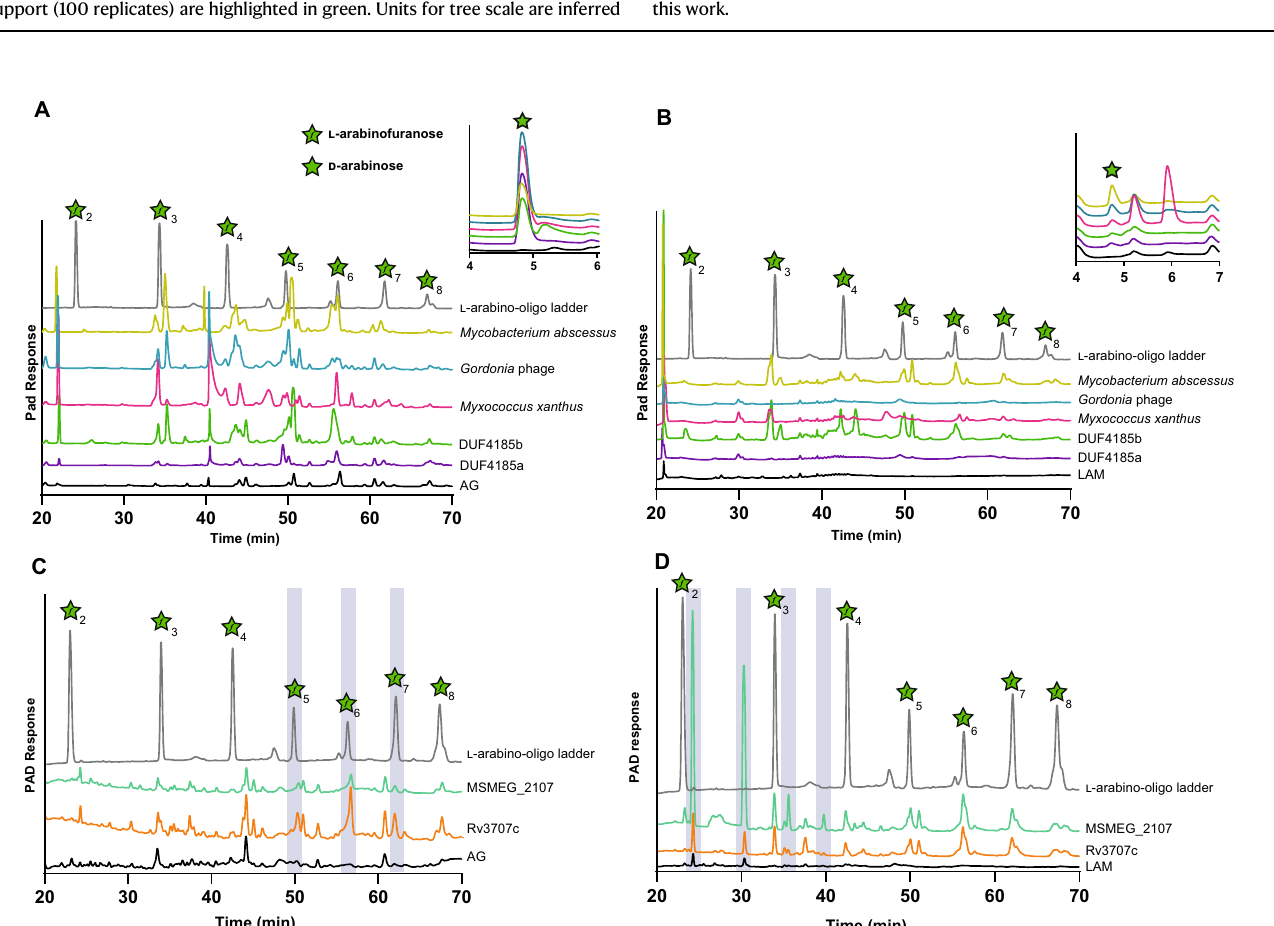
Fig. 3 | Phylogeny of the DUF4185 enzyme family. Unrooted ML phylogeny (LG model with empirical base frequencies, invariable sites and the discrete gamma model) of DUF4185 family sequences. Branches with greater than 75% bootstrap support (100 replicates) are highlighted in green. Units for tree scale are inferred